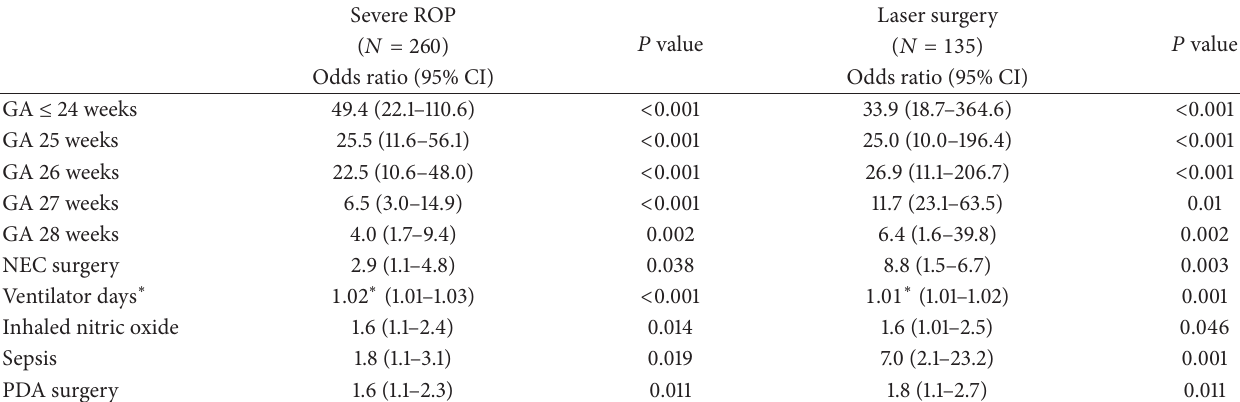
Table 2: Combined logistic regression coefficients for infants with severe retinopathy of prematurity (ROP) or laser surgery.